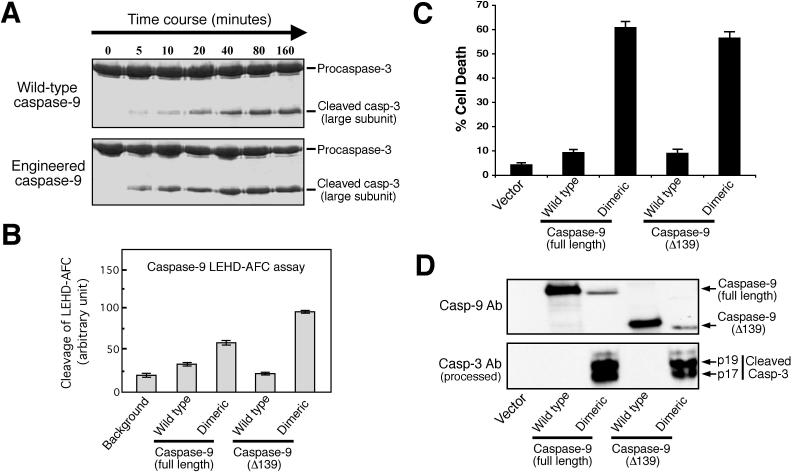
The Dimeric Caspase-9 Exhibits Higher Catalytic Activity and Stronger Cell-Killing Activity than the WT Protein(A) A time course experiment of caspase-9 activity using procaspase-3 (C163A) as the substrate revealed that the dimeric caspase-9 (residues 1–416) exhibited an approximately 5-fold higher level of catalytic activity than the monomeric WT caspase-9. The concentrations were: WT and engineered caspase-9, 0.5 μM; procaspase-3 (C163A), 33 μM.(B) Comparison of catalytic activity for the WT and dimeric caspase-9 using fluorescent substrate LEHD-AFC. Both the full-length and Δ139 dimeric caspase-9 displayed higher activities than their WT counterparts.(C) The dimeric caspase-9 induced apoptosis more effectively than the WT protein. Mammalian expression vector pcDNA3 constructs encoding WT or dimeric caspase-9 were transfected into HeLa or 293 cells. The extent of cell death induced by each construct was examined.(D) The dimeric but not the WT caspase-9 promoted the activation of caspase-3. The expression of caspase-9 variants (upper panel) and the processing of caspase-3 (lower panel) from the cell extracts were detected by antibodies against caspase-9 and -3, respectively. No endogenous caspase-9 band was visible in the vector-transfected cells at lower exposure.